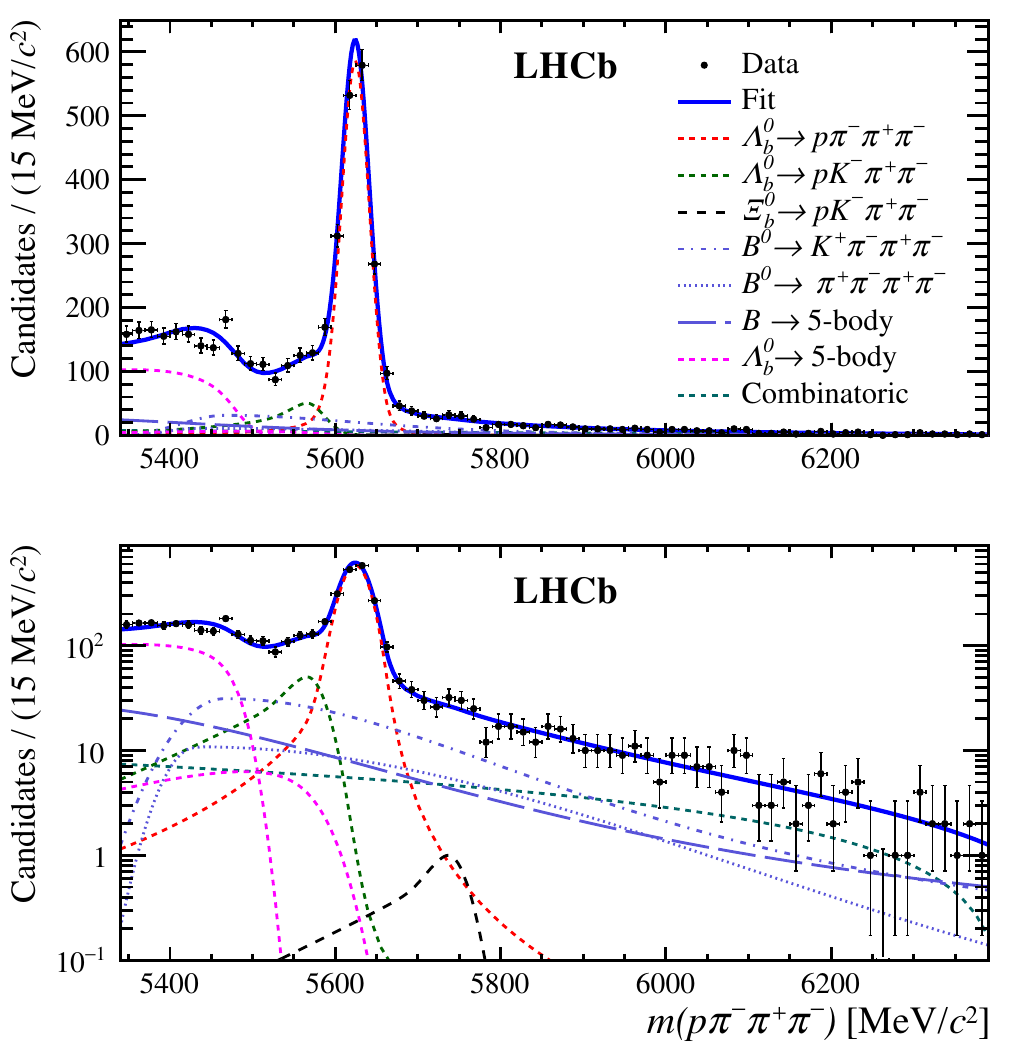
Figure 1 . Results of the (cid:12)t to the p(cid:25) (cid:0) (cid:25) + (cid:25) (cid:0) candidate mass spectrum with (top) linear and (bottom) logarithmic scales. The di(cid:11)erent components employed in the (cid:12)t are indicated in the legend. The (cid:3) 0 ! 5-body legend describes two components, the radiative partially reconstructed b background (cid:3) 0 ! p(cid:25) (cid:0) (cid:17) 0 and the partially reconstructed background (cid:3) 0 b (cid:25) 0 is not reconstructed. The latter has a lower-mass